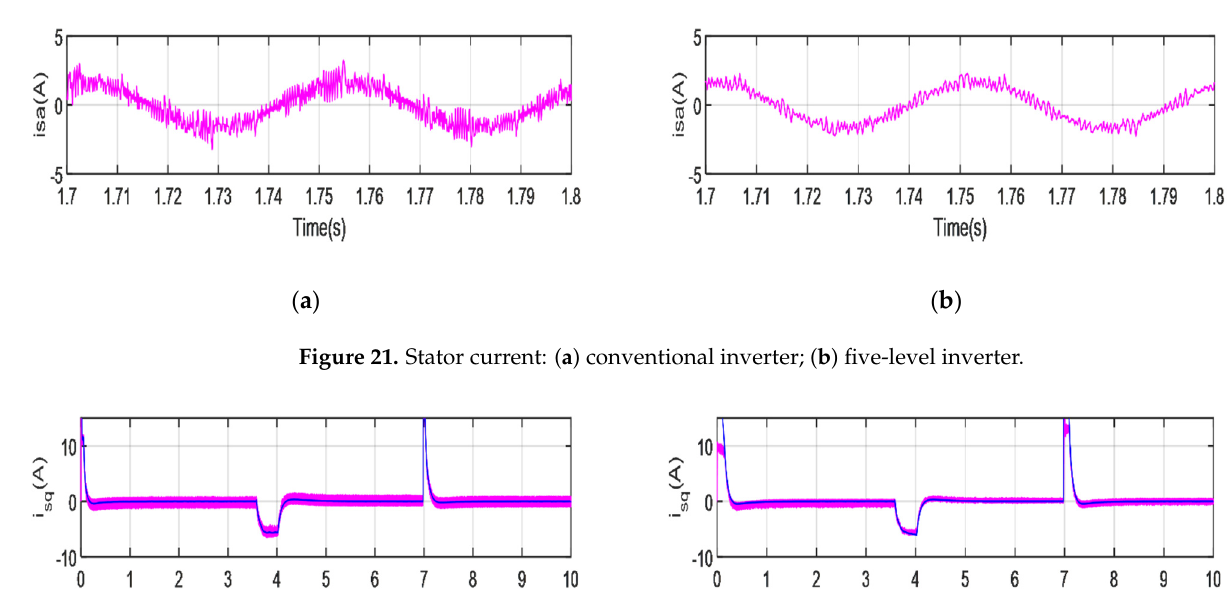
Figure 20. Torque response: ( a ) conventional inverter; ( b ) five-level inverter.